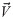
Two surfaces of an object close to the radar have a the same velocity V→ but different radial velocity VR.